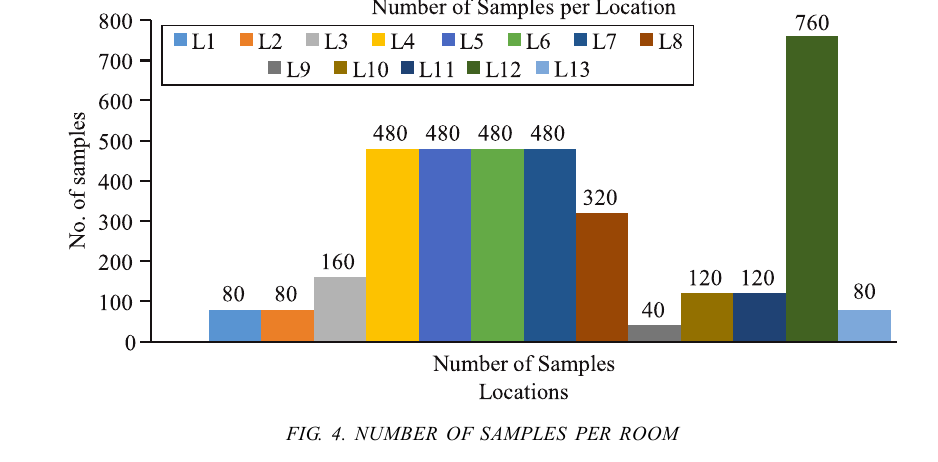
FIG. 4. NUMBER OF SAMPLES PER